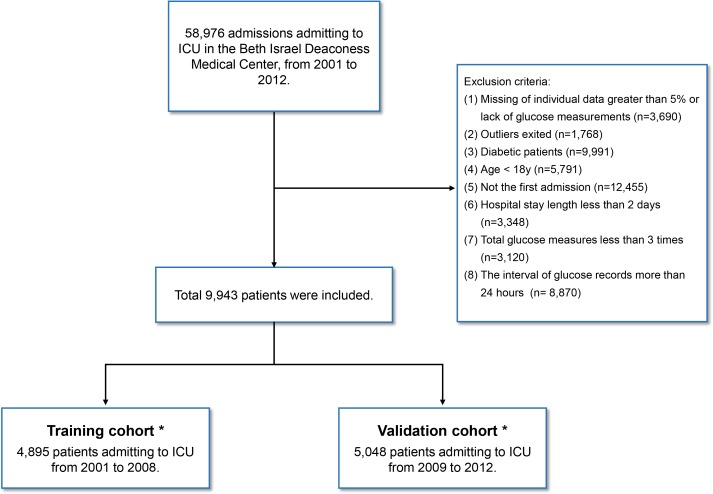
A flow diagram of study participants.*There is no overlap between training and validation cohorts.